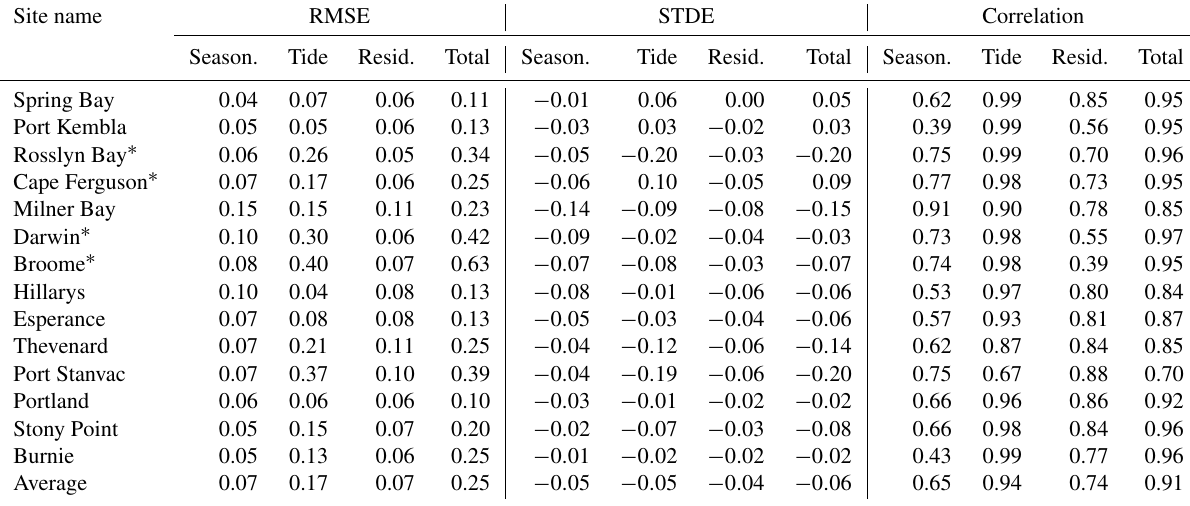
Table 2. Root mean square errors (RMSEs), mean standard deviation errors (STDEs) and correlation coefficients for the astronomical tide, residual, seasonal signal and total water levels for the period 1993 to 2012 (except for Port Stanvac, which is over the period 1993–2009). For sites marked with ( ∗ ) a 24h running mean was applied to both the de-tided observations and model simulations to remove noise arising from the de-tiding process that was most pronounced at these